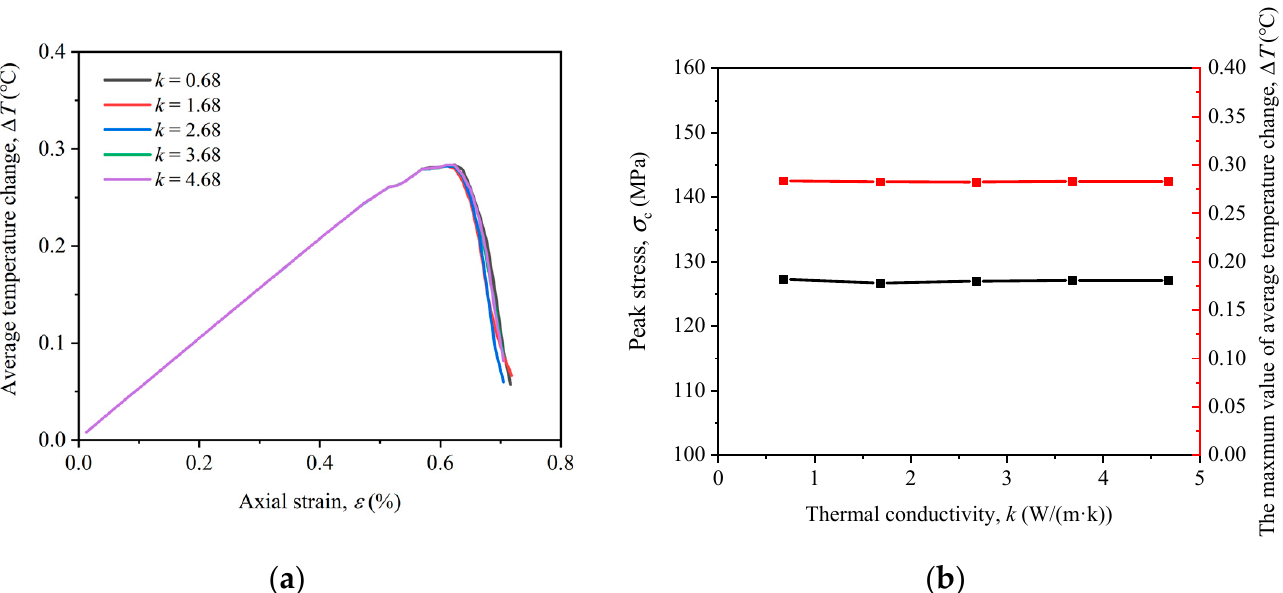
Figure 10. Effect of different thermal conductivity on average temperature change ( a ); peak stress and the maximum value of average temperature change ( b ).